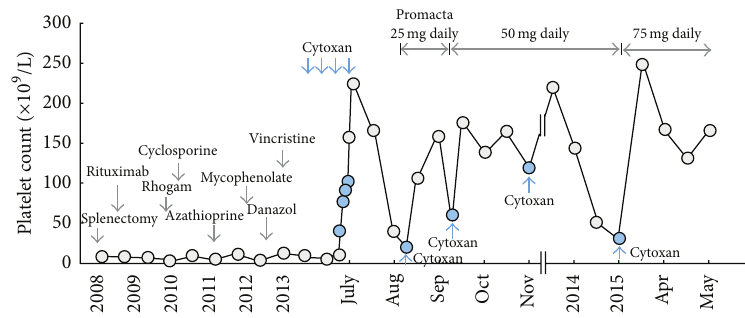
Figure 1: Platelet response to sequential treatments for